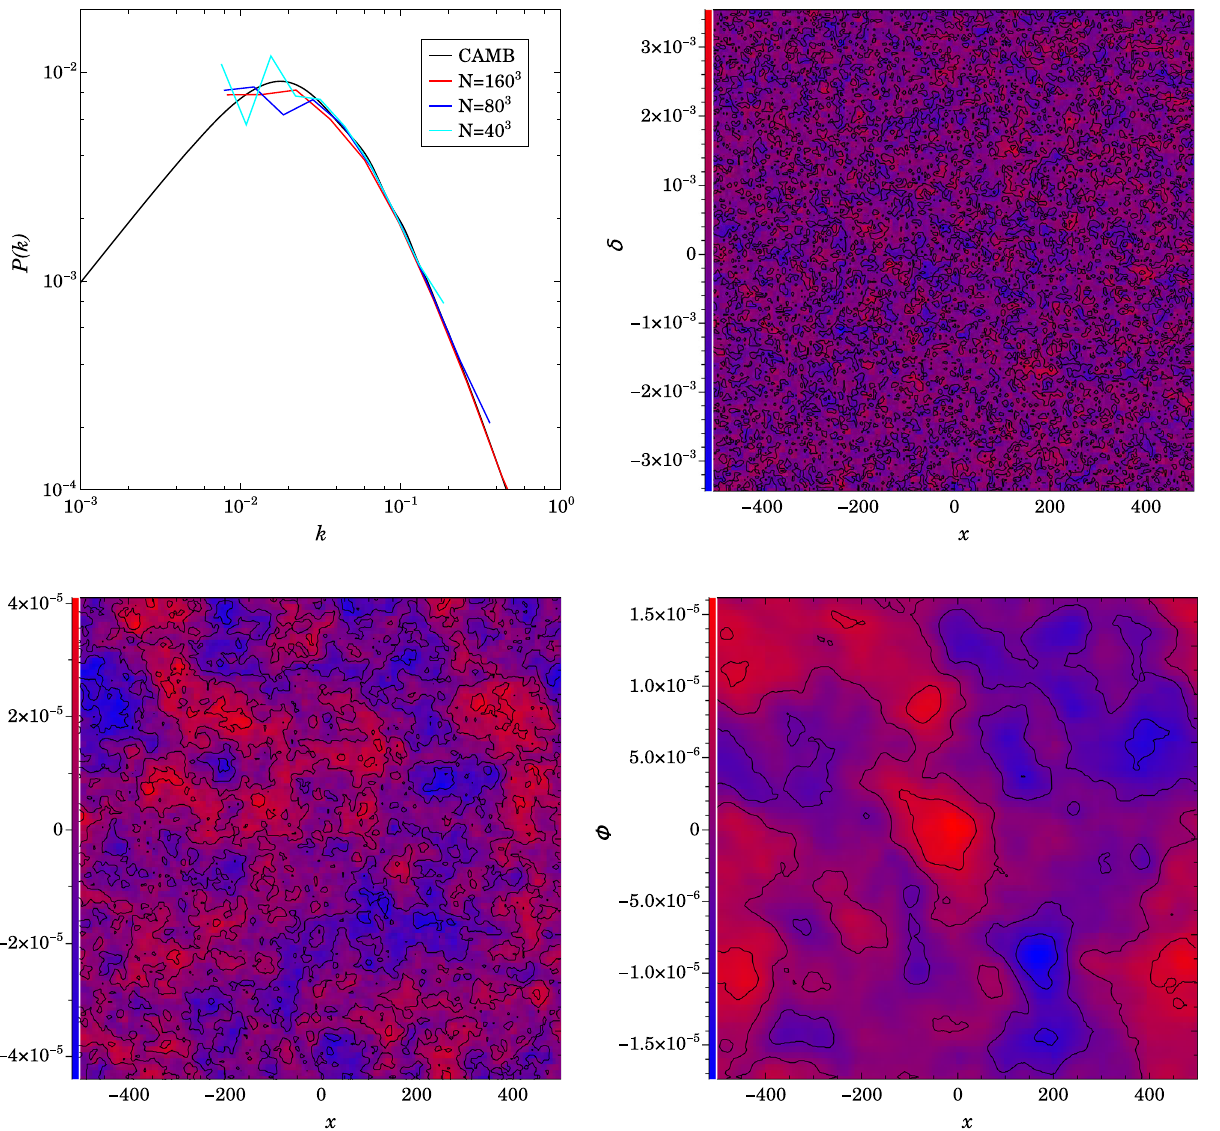
40 3 resolution respectively, while δ( x i ) is generated by the function make_gaussian_random_field in c2raytools from the black curve. The second plot is the distribution of δ( x i ) at a S = 1 and 160 3 res- olution. The last two plots are the distribution of v x ( x i ) and (cid:6)( x i ) at a S = 1 respectively, which are derived from δ( x i ) according to the Fourier version of